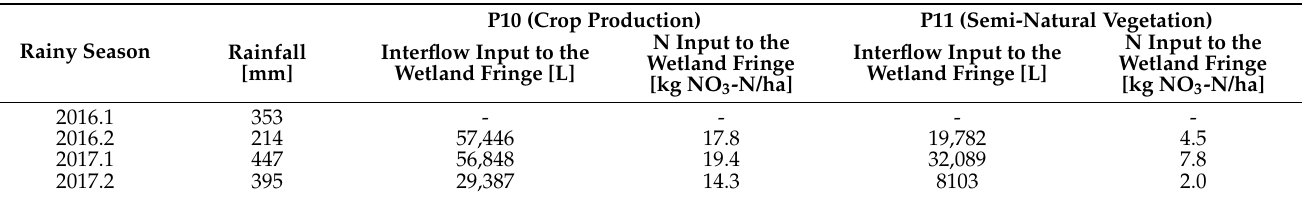
Table 4. Seasonal input of water and nitrate to the wetland fringe by the interflow in the four rainy seasons in 2016 and 2017. Values embrace the rainy, as well as the following dry season, to account for the delayed component of the